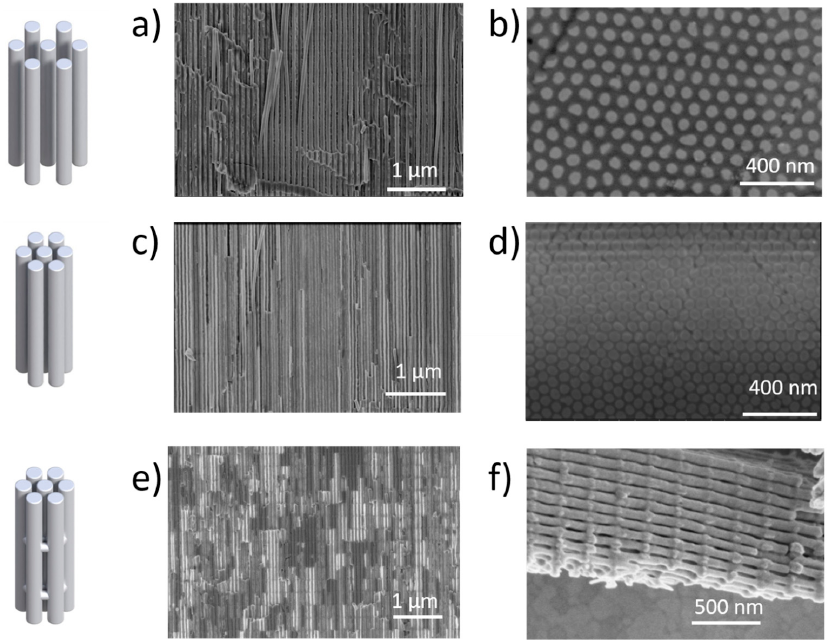
Figure 2. Scanning electron microscopy images of the different nanostructures fabricated with Bi 2 Te 3 , in side view ( a , c , e ) and top view ( b , d ) before dissolving the alumina template. The schemes of the different structures (as shown in Figure 1) are displaced on the left hand of the figure in the same row as their SEM counterparts. ( a , b ) correspond to the 1D nanowire array with the nanowire inter-distance of 100 nm (side and top views, respectively), ( c , d ) correspond to the 1D nanowire array with nanowire inter-distance of 65 nm (side and top views, respectively), and ( e , f ) correspond to the 3D nanowire network, ( e ) being the side view inside the 3D-AAO template and ( f ) after dissolving the 3D-AAO